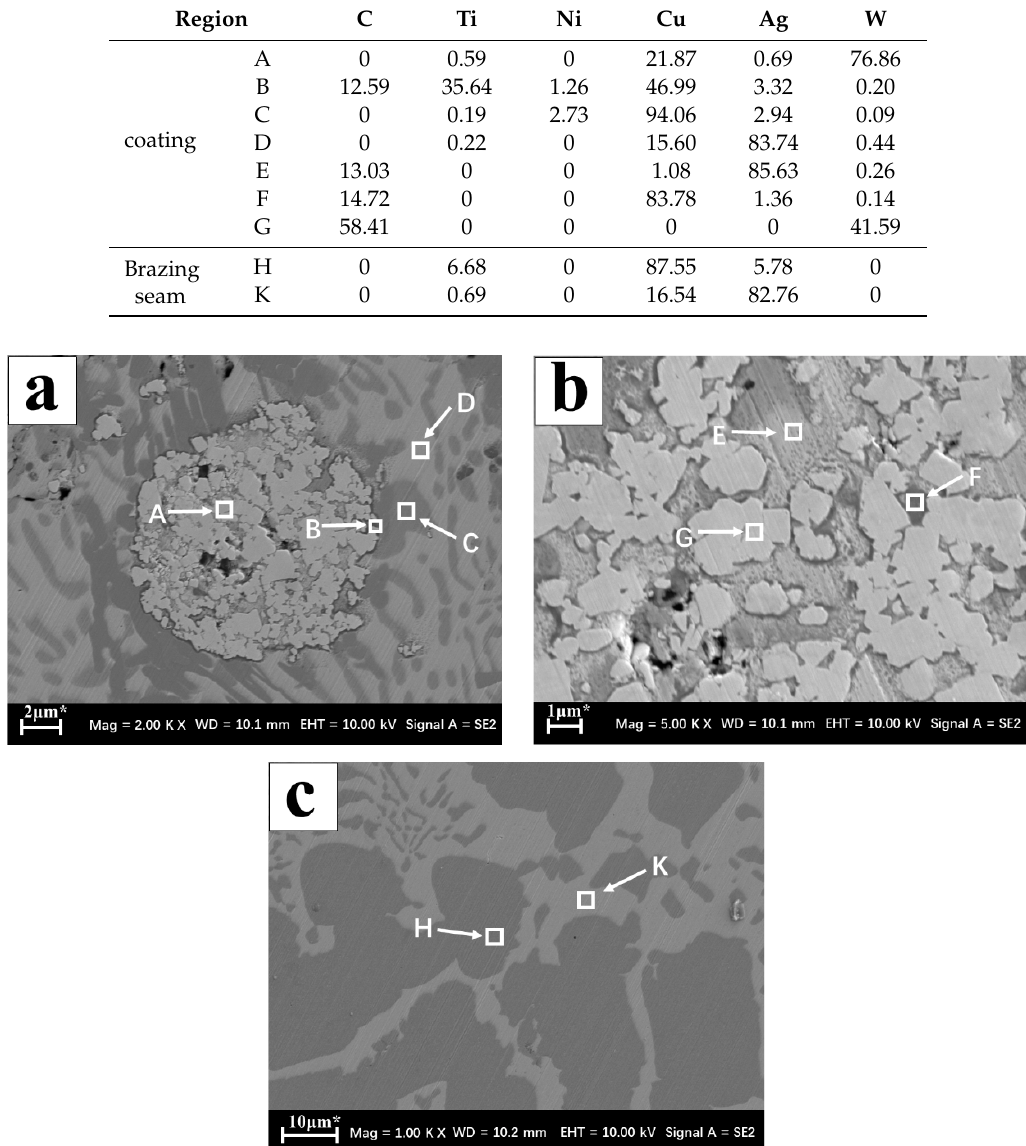
Table 1. Element distribution results at each point in Figure 6 (at.%).